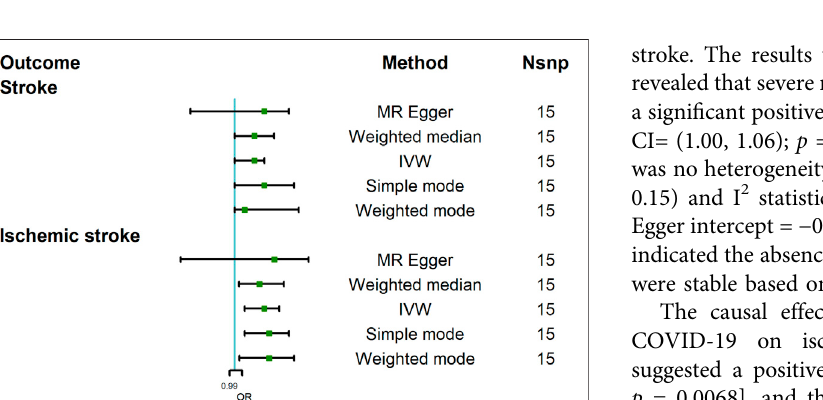
Frontiers in Genetics |